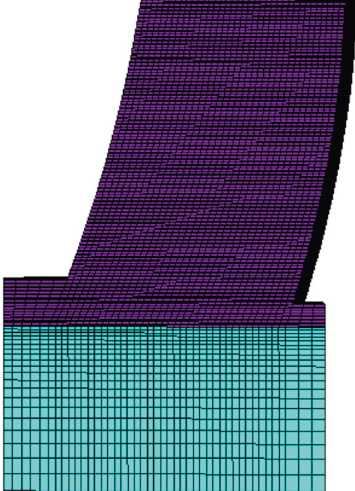
Figure 8: The finite element model of the block